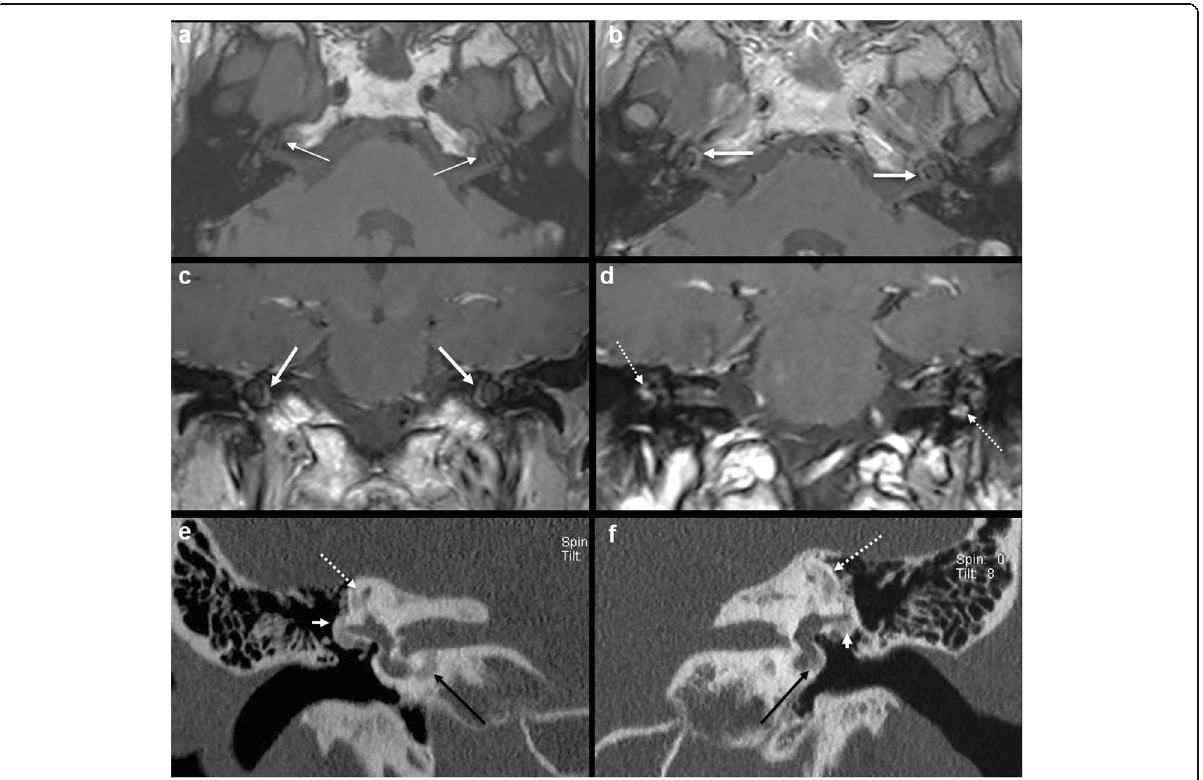
Fig. 4 A 57-year-old female patient with left-sided SNHL (case 3). Axial T1W MR image ( a ) shows intermediate T1 signal in in bilateral pericochlear regions (arrows). Contrast-enhanced axial T1W MR image ( b ) and contrast-enhanced coronal T1W MR image ( c ) show ring-like enhancement in bilateral pericochlear regions (arrows). Contrast-enhanced coronal T1W MR image ( d ) also shows patchy enhancement surrounding the SCC bilaterally (dashed arrows). Subsequent coronal HRCT images ( e , f ) confirm otosclerotic plaques adjacent to bilateral lateral SCC (short white arrow), superior SCC (dashed arrow) and in bilateral pericochlear regions (long black